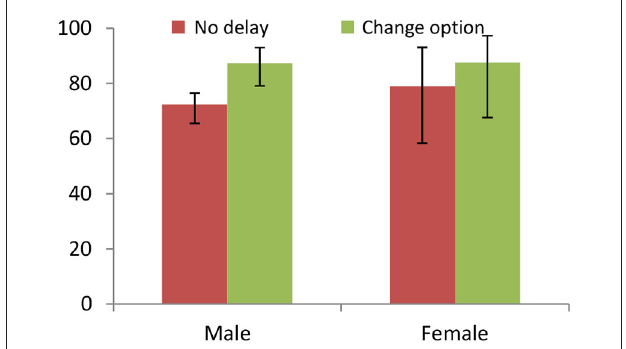
FIGURE 5 | The acceptance rate of proposals by Responders in the Ultimatum Game (UG) for the no delay and change treatments (Grimm and Mengel, 2011), disaggregated by gender . The treatment effect is only significant for males and robust to considering low offers.